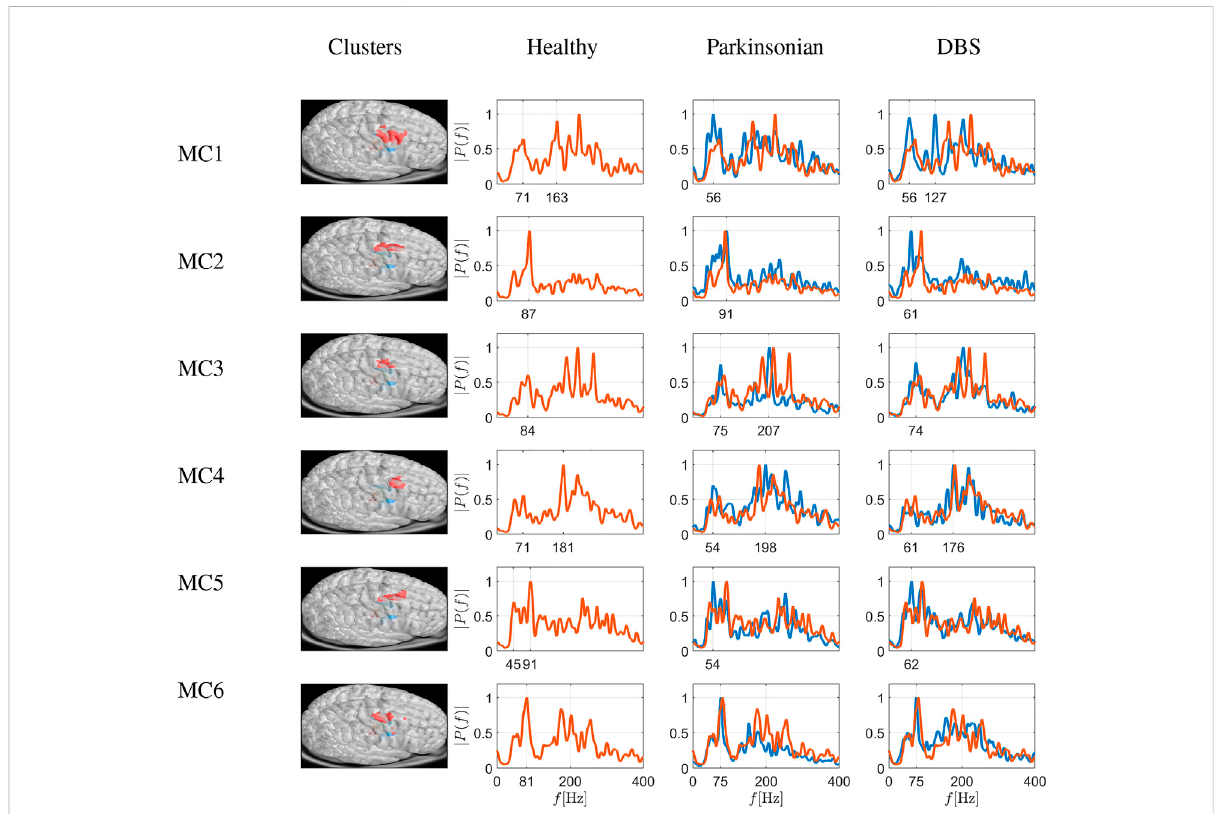
FIGURE 7 Simulation of frequency spectrograms of cortical sets of nodes as average neuronal activity (power on ordinate given as relative value) in a frequencyrangeof0 – 400 Hz.Thesixrowsdepictsixdifferentcorticalnodesets(sixclustersemergingfrommodularityanalysis)showninredonthe virtual brain surface. The spectrograms correspond to healthy conditions (red traces), Parkinsonian conditions and DBS in a Parkinson-affected network (both as blue traces), as shown in the different columns. Traces from healthy conditions are superimposed as fi ne red traces. Under healthy conditions, the activity peaks in the low and high γ band (i.e., ≈ 80 Hz and ≈ 190 – 290 Hz, with one to three peaks). Under Parkinsonian conditions, these peaks are generally blunted, and DBS is able to reverse this at least in some instances (e.g., clusters in MC3, MC4 and MC5, where spectrograms under DBS deviate less from healthy conditions than spectrograms under Parkinsonian conditions by as much as 17 – 28%, taking the overall area under the curve differences as a measure; see Figure